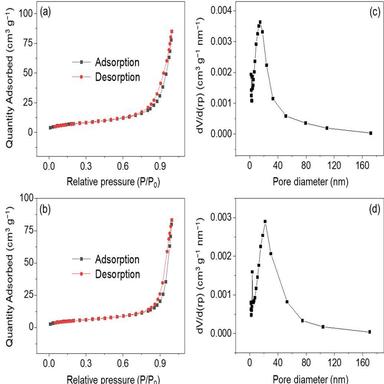
N2 adsorption–desorption isotherms of (a) MnCo2O4-discs and (b) MnCo2O4-rings, and the BJH pore size distribution of (c) MnCo2O4-discs and (d) MnCo2O4-rings.